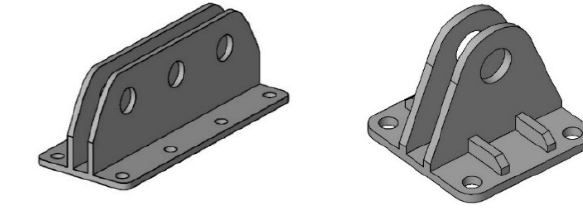
Figure 8. Components based in C-shaped steel beam.